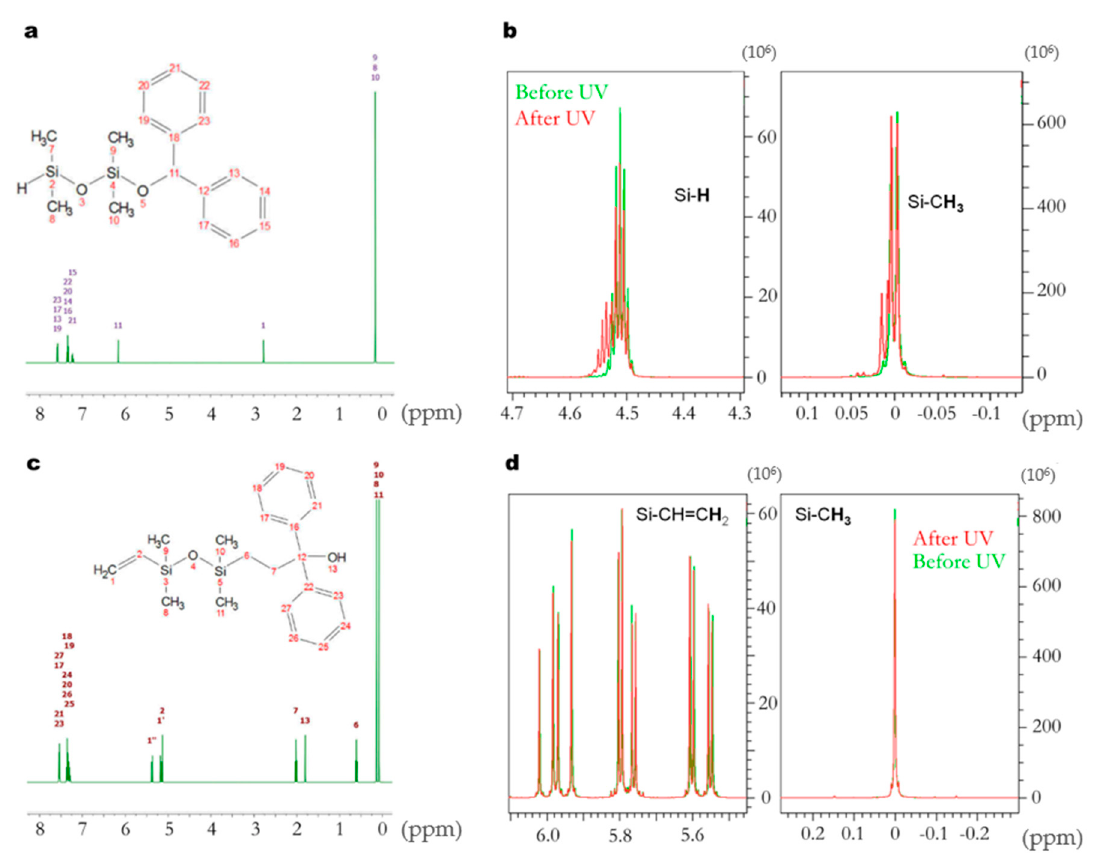
Figure 4. ( a ) Simulated proton NMR spectra of M 2H reacting with benzophenone. ( b ) Proton NMR spectra prior (in green) and after (in red) irradiation of M 2H + benzophenone mixture. ( c ) Simulated proton NMR spectra of M 2V reacting with benzophenone. ( d ) Proton NMR spectra prior (in green) and after (in red) irradiation of M 2Vi reacting with benzophenone. Note that the peaks are normalized by superimposing peaks of the Si-CH 3 .